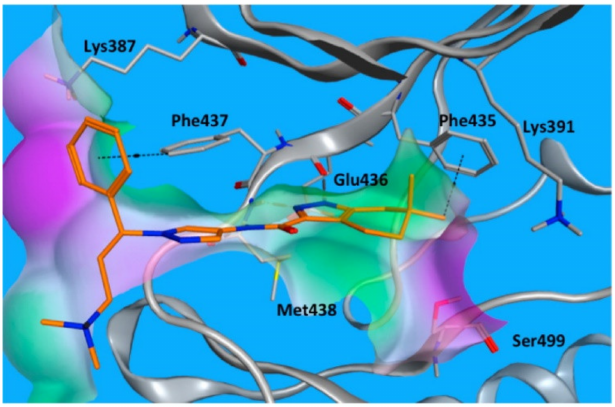
Figure 41. Co-crystal binding interactions of GNE-9822 (compound 38 ) with ITK